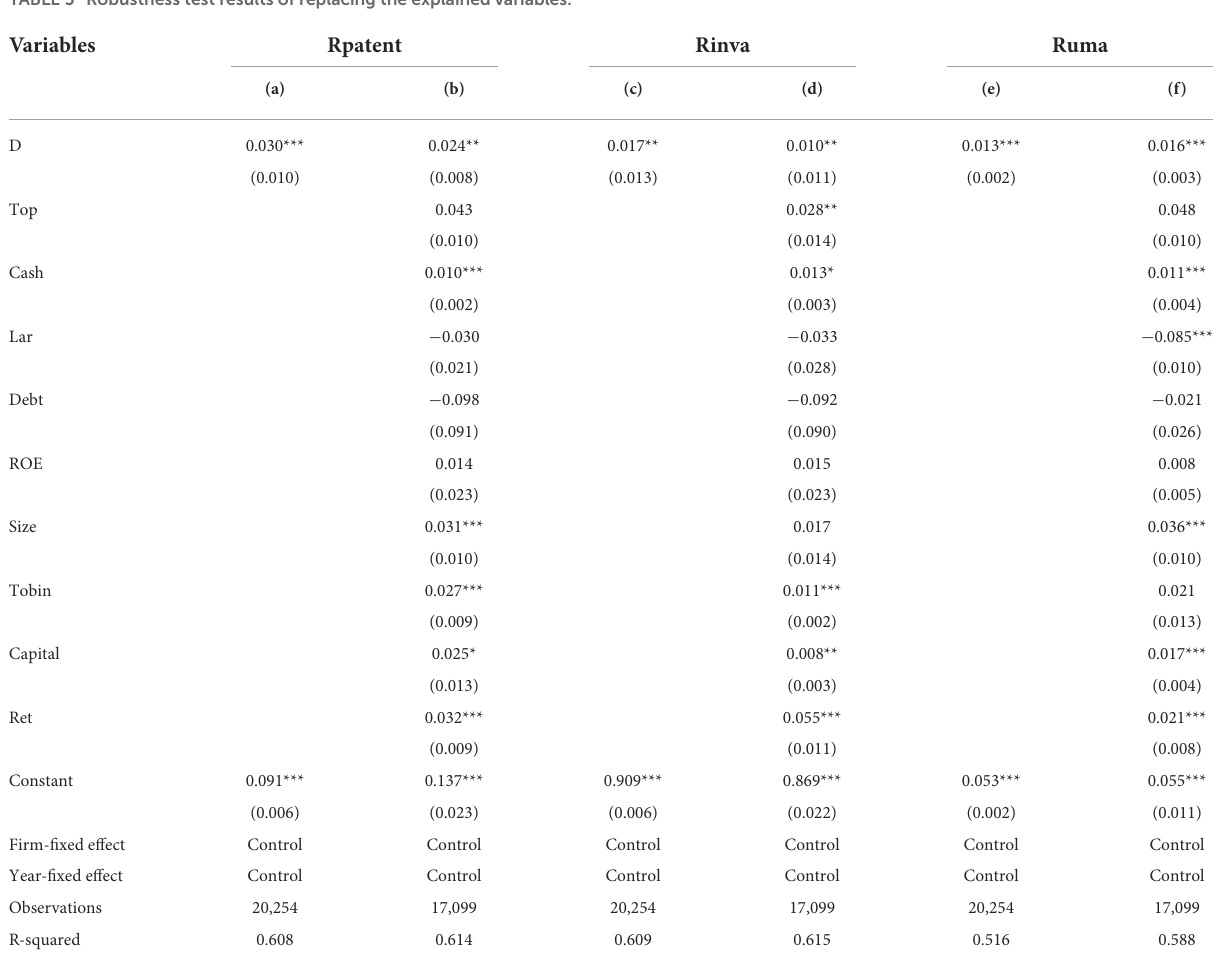
TABLE 5 Robustness test results of replacing the explained